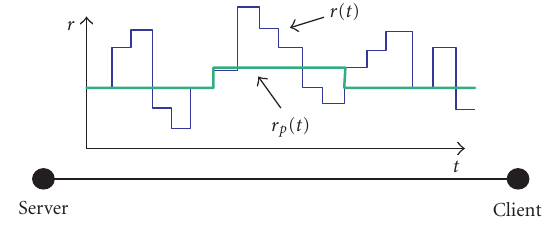
Figure 2: Network end-to-end model with rate variations r ( t ) and estimated rate r p ( t ).